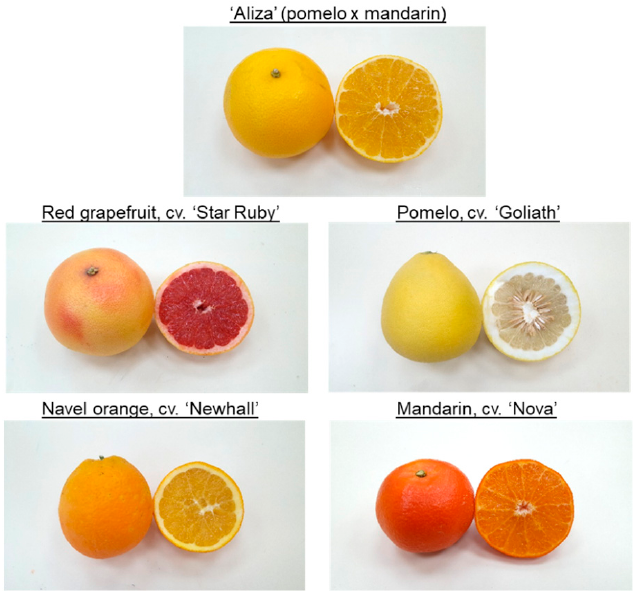
Figure 1. Photographs of ‘Aliza’, grapefruit, pomelo, orange and mandarin fruits used in this study.